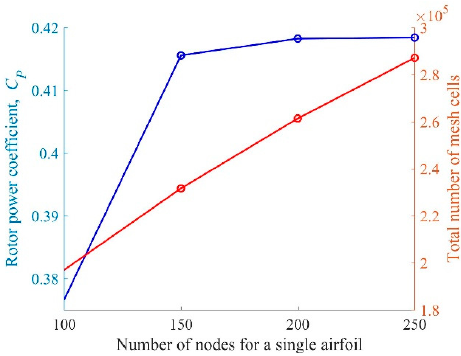
Figure 18. Influence of mesh density on the rotor power coefficient and the total number of grid